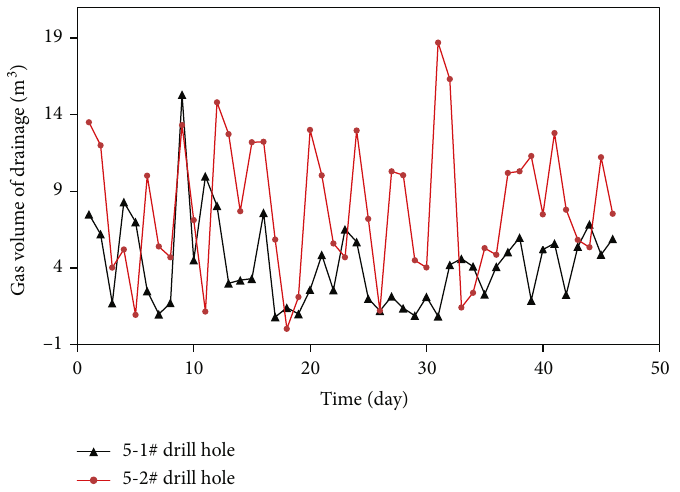
Figure 10: Gas extraction in the borehole group